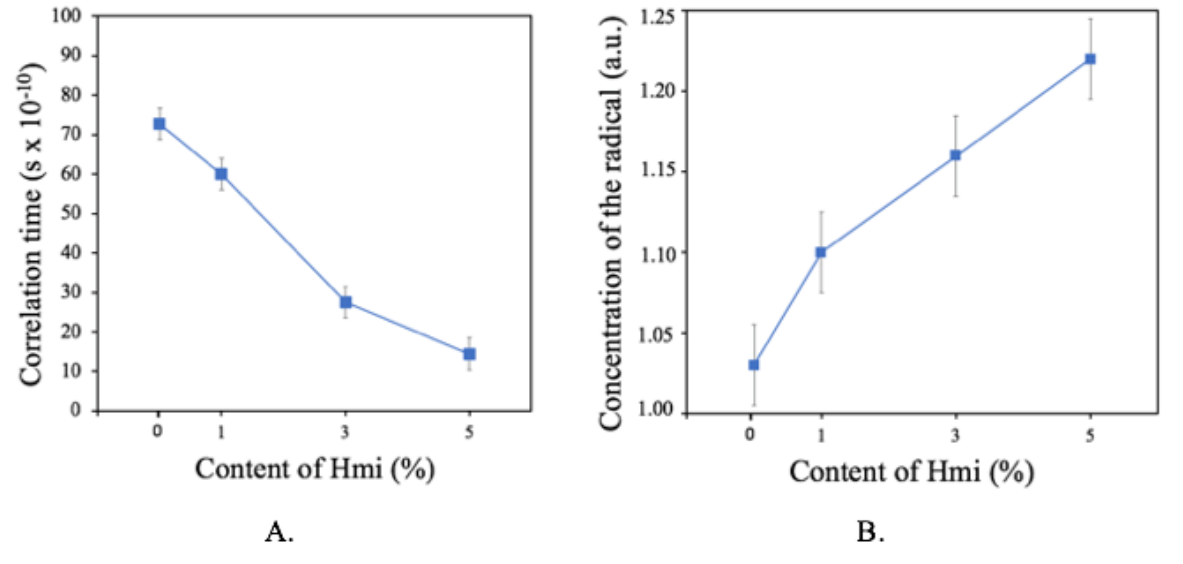
Figure 7. Correlation times ( A ) and concentration of TEMPO ( B ) versus the content of Hmi in the Hmi /PHB material.